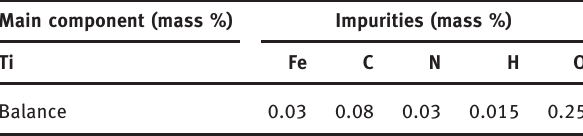
Table 1: Chemical composition of as-received TA2 billet.